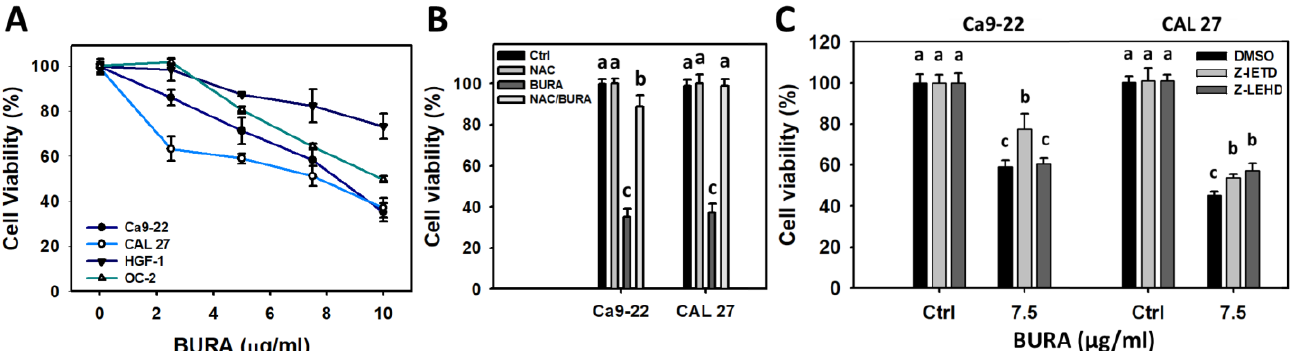
Figure 1. Cell viabilities of oral cancer cells following BURA exposure. ( A ) 24 h MTS assay. ( B ) NAC effects on cell viability of BURA-treated oral cancer cells. After NAC (10 mM, 1 h) treatments or not, oral cancer cells (Ca9-22, CAL 27, and OC-2) and normal oral cells (HGF-1) were treated with BURA (0 (control) and 10 µ g/mL (33.8 µ M)) for 24 h. NAC/BURA indicate the pre-and post-treatment. ( C ) Effects of Cas 8 and Cas 9 inhibitors on cell viability of BURA-treated oral cancer cells. After Cas 8 and Cas 9 inhibitor treatments (10 µ M, 2 h), cells were treated with BURA (7.5 µ g/mL (25.3 µ M)) for 0 (control) for 24 h. Data, mean ± SD ( n = 3). Data top-labeled with non-overlapping lower-case letters differ significantly with respect to multi-comparisons of the same cell line ( p < 0.05).